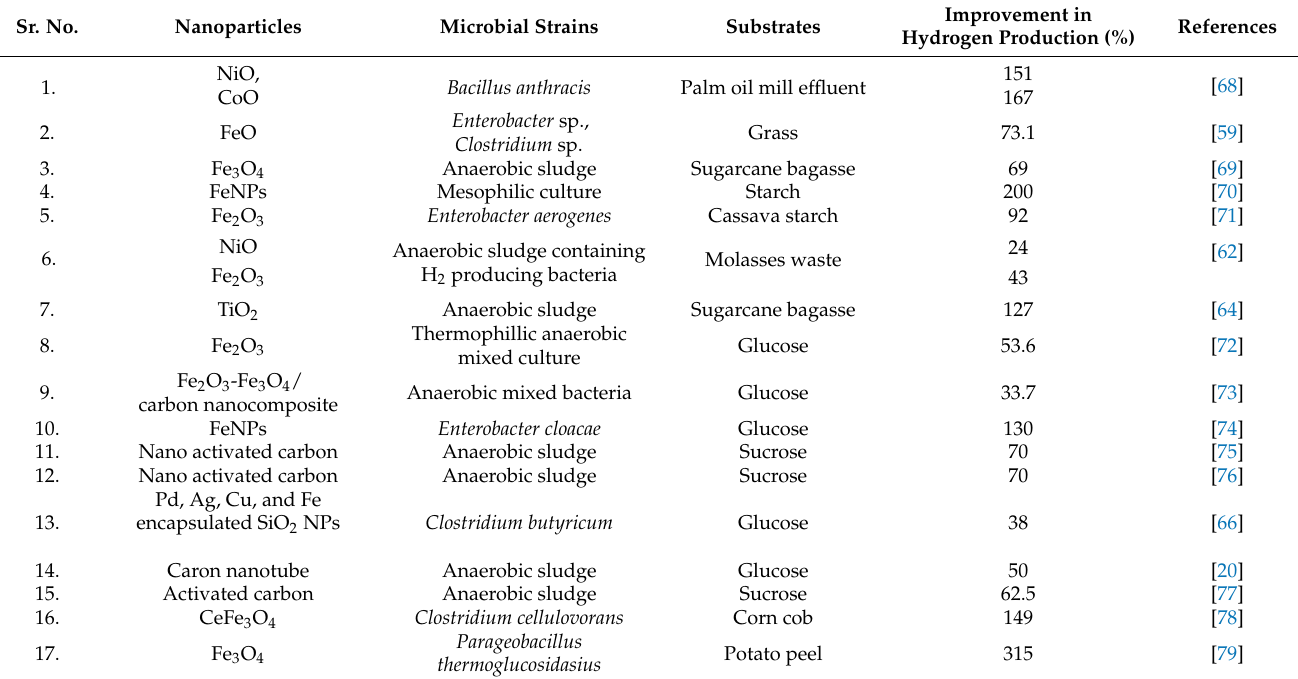
Table 2. Influence of various nanoparticles on hydrogen production using different substrates. Sr.